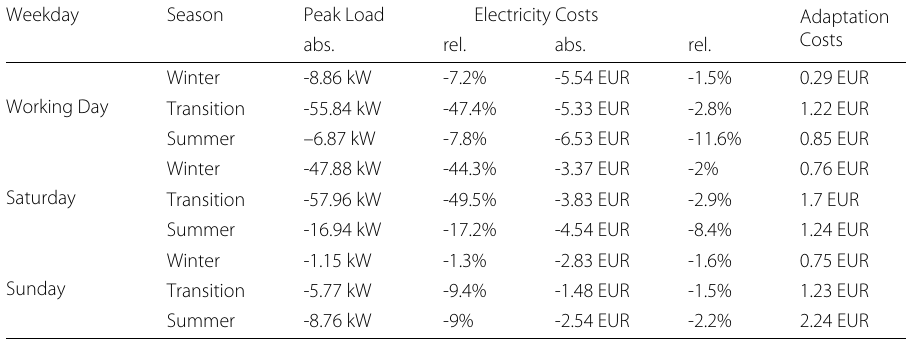
Table 2 Effect of the optimization regarding the multiple objectives for the different simulated days in the urban grid Season Peak Load Costsabs. rel.